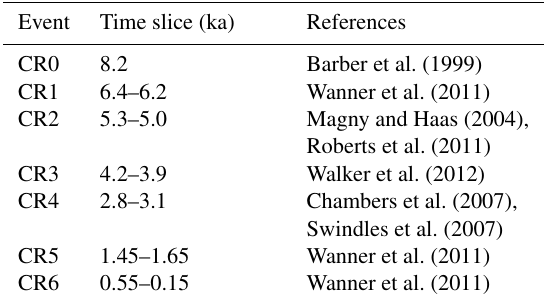
Table 1. Chronology of Holocene cold relapses (CRs) based on ex- isting